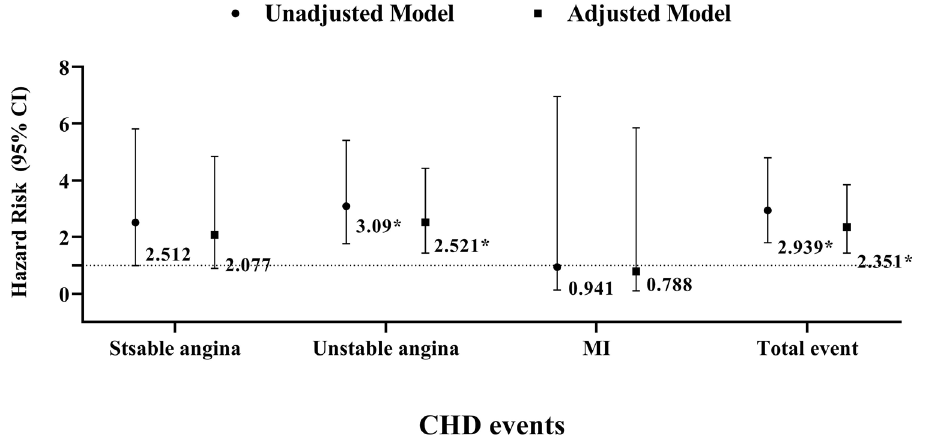
Figure 2. Cox regression model, CHD events and nightly sleep (≥ 5 h and < 5 h); *p <